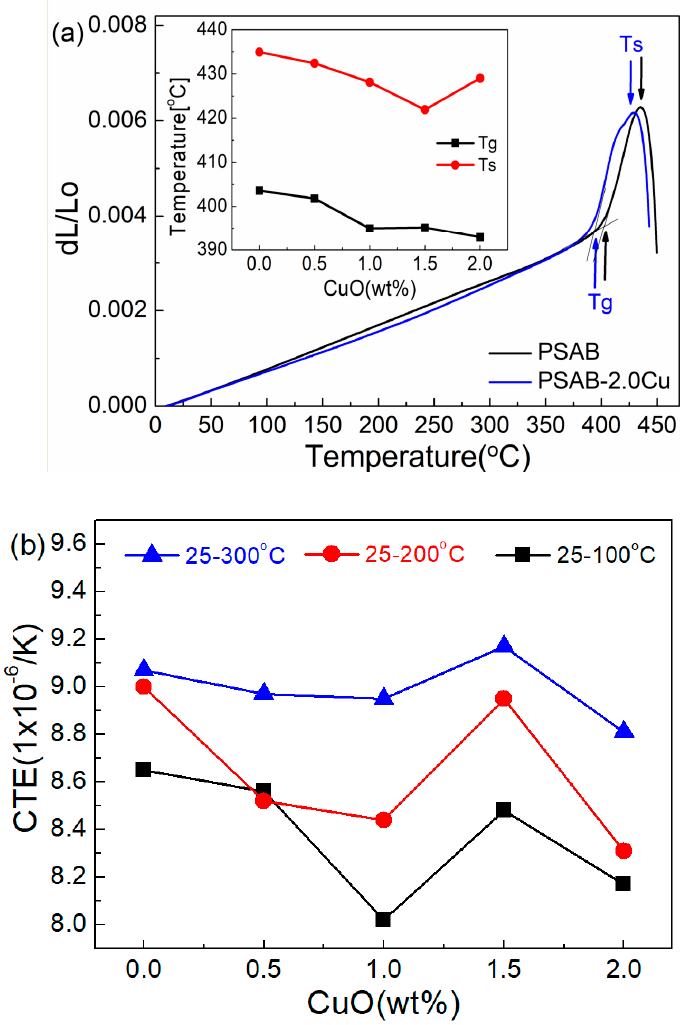
Figure 2. ( a ) Thermo-mechanical analysis (TMA) traces of the PSAB system doped with various CuO concentrations; and ( b ) the variation of coefficient of thermal expansion (CTE), dependent on CuO concentration for different temperature ranges; inset shows the variation of T g and T s , dependent on CuO concentration.